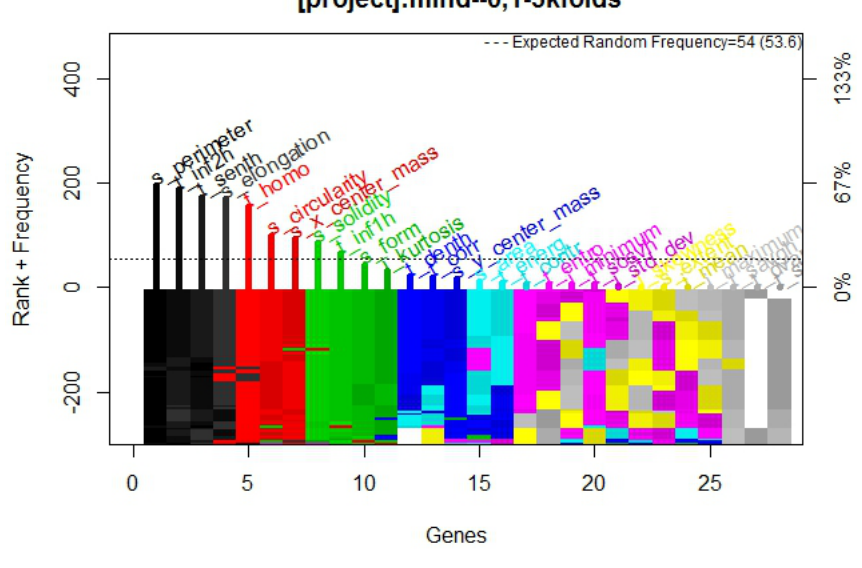
Figure 2. Gene rank stability graph obtained from Galgo algorithm with RF